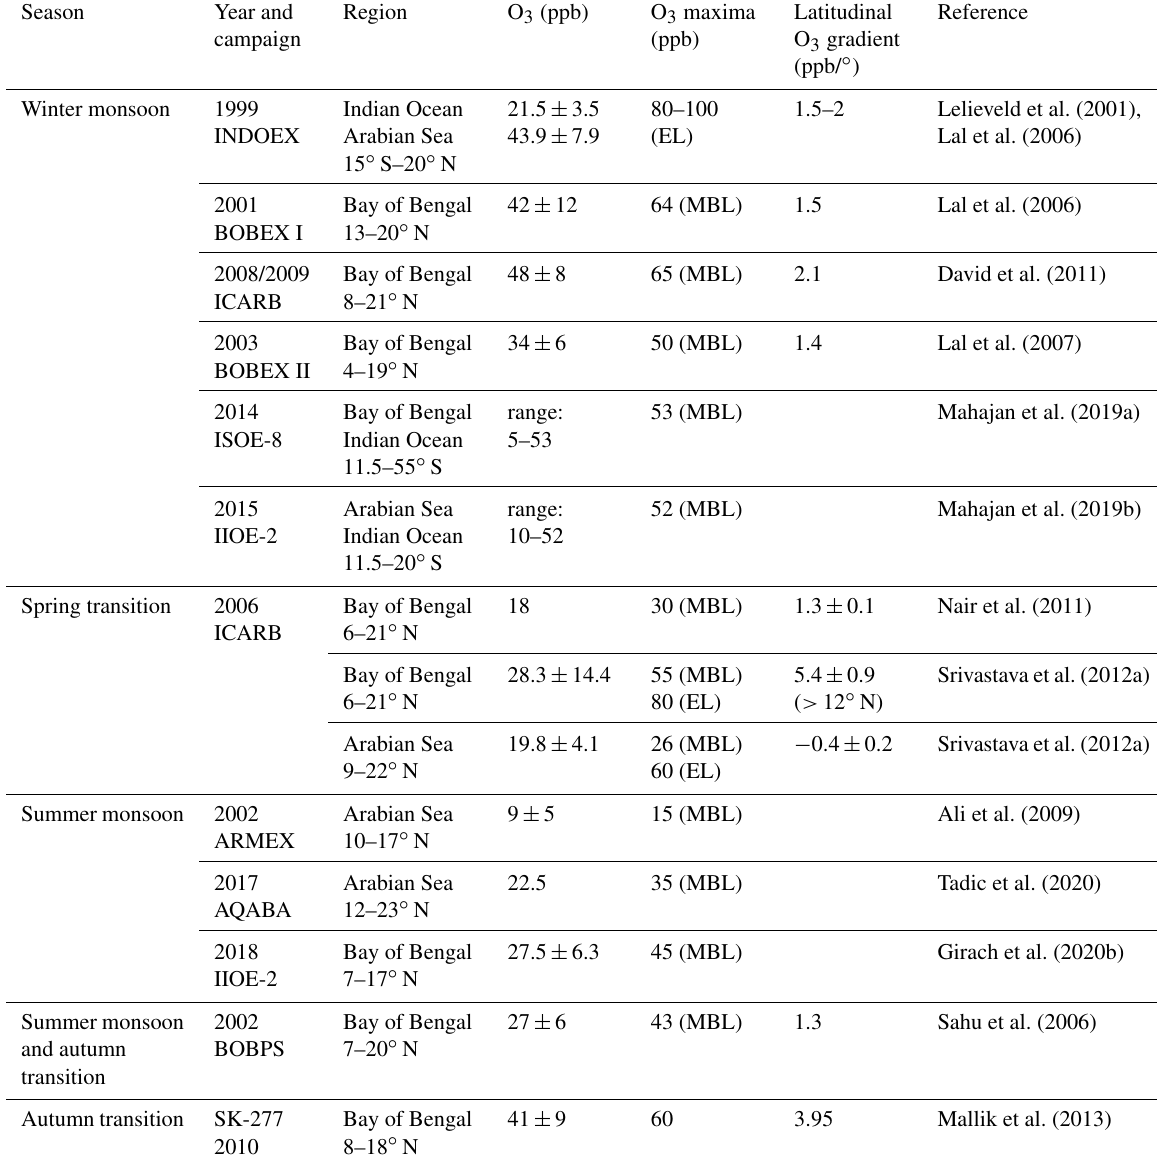
Table 4. Ozone (O 3 ) mean values (ppb) and latitudinal gradients reported for various campaigns in the Bay of Bengal, Arabian Sea, and Indian Ocean. Ozone maximum values are given in the marine boundary layer (MBL) and in the elevated layer (EL), as